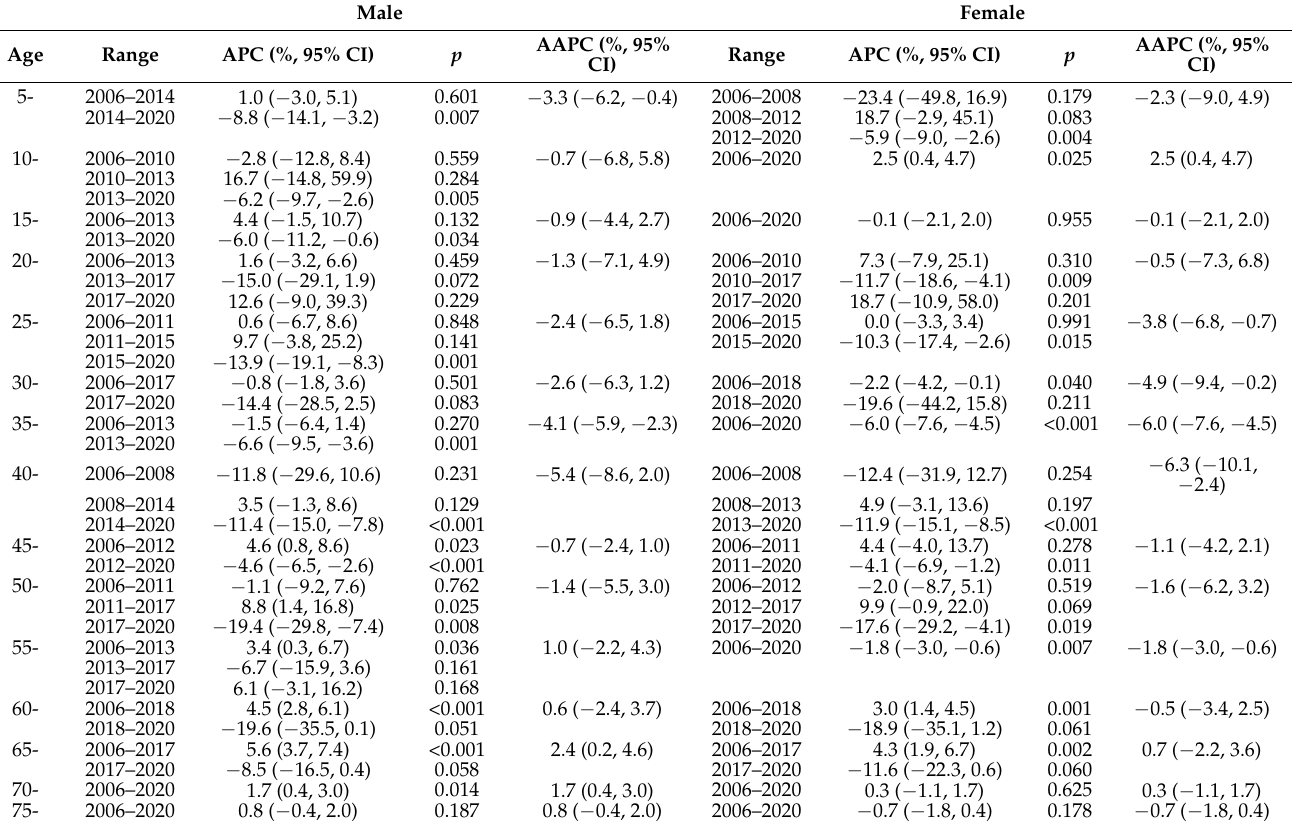
Table A1. The temporal trends in age-specific mortality rates for each age group in urban regions using Joinpoint regression analysis.